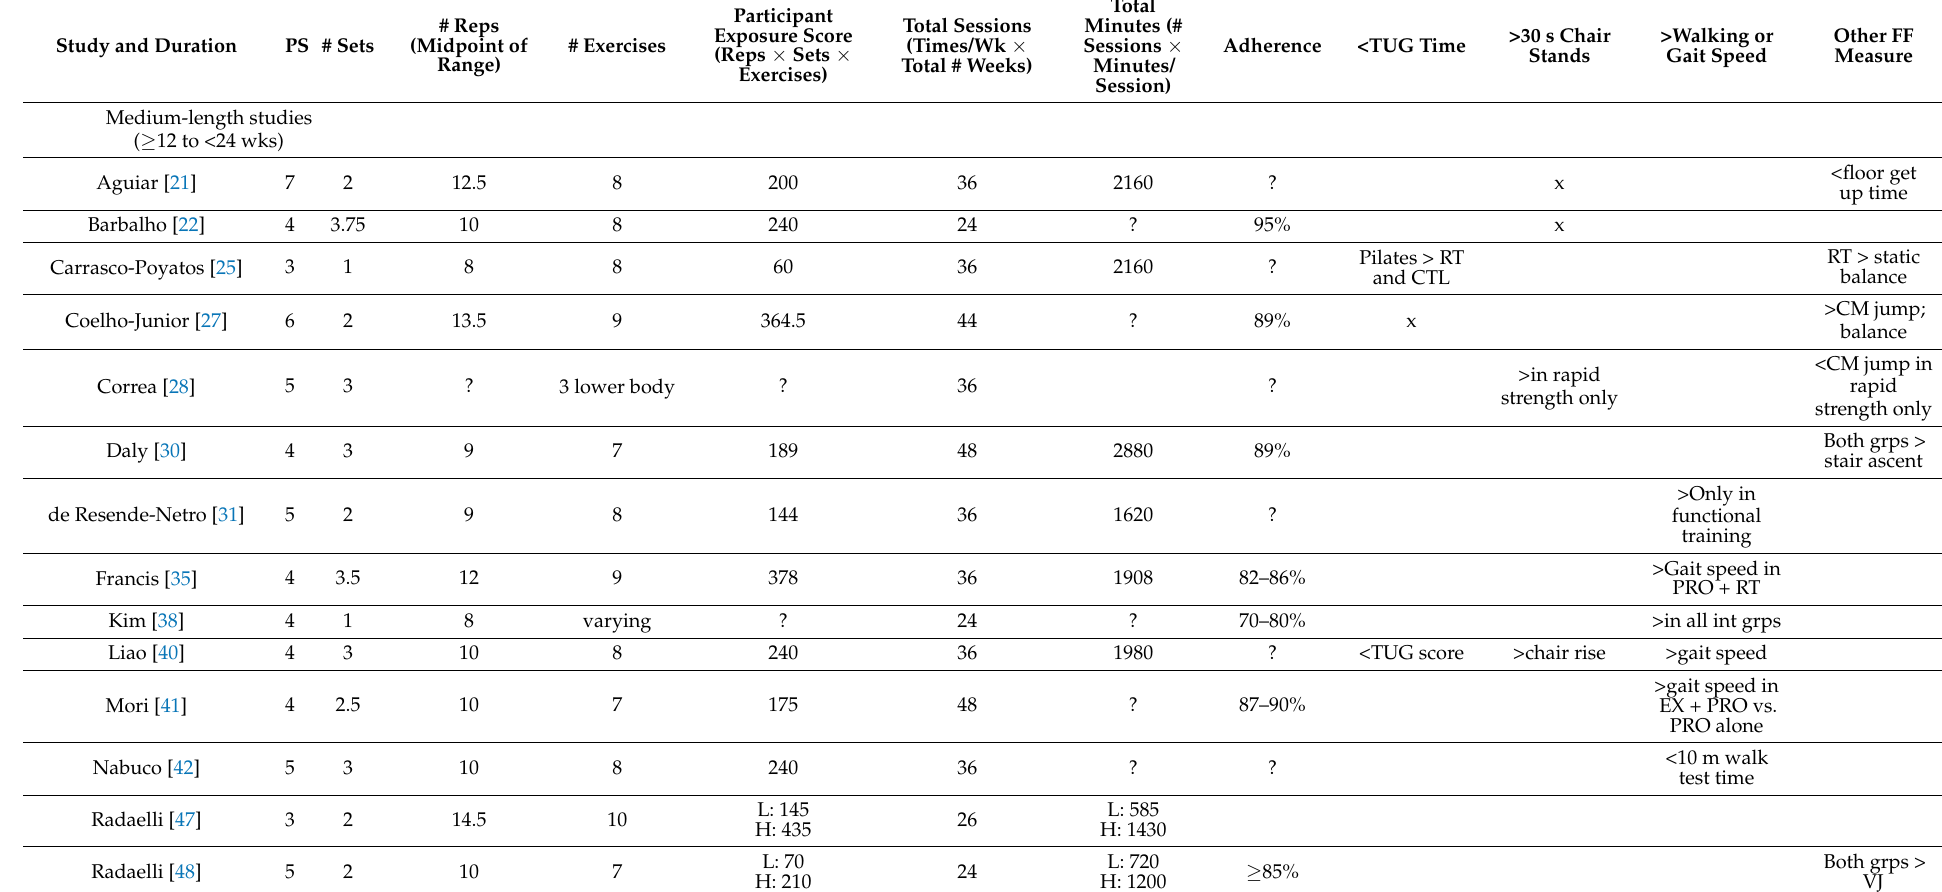
Table 6. Summary of impact of participant exposure, study duration, and adherence on functional fitness (FF) in older